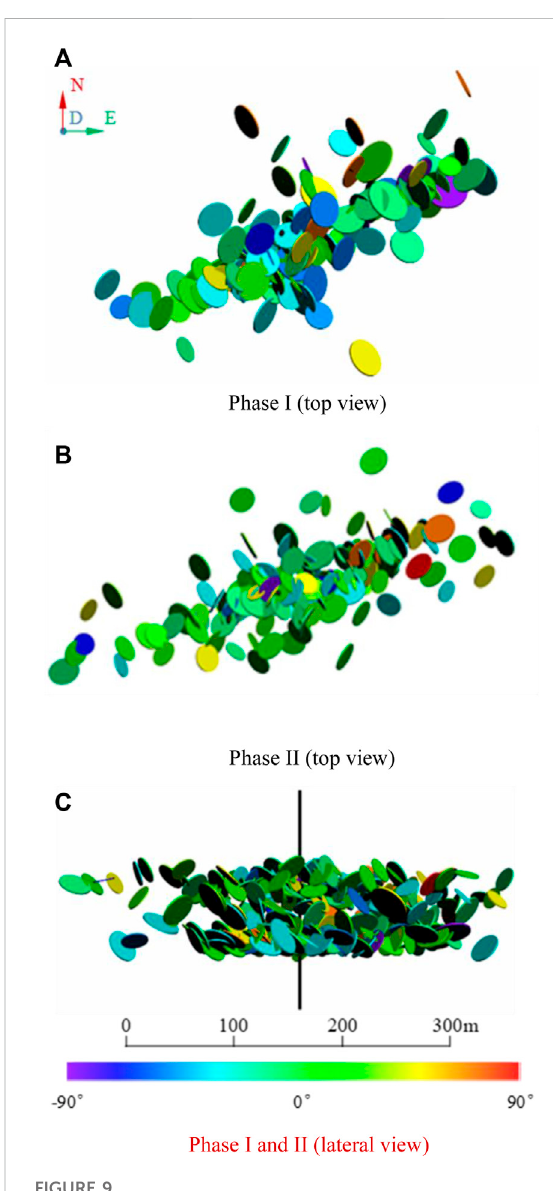
FIGURE 9 Microseismicity-derived discrete fracture network for different fracturing stages. (A) , Phase I(top view); (B) , Phase II(top view); (C) , Phase I and II (lateral view).